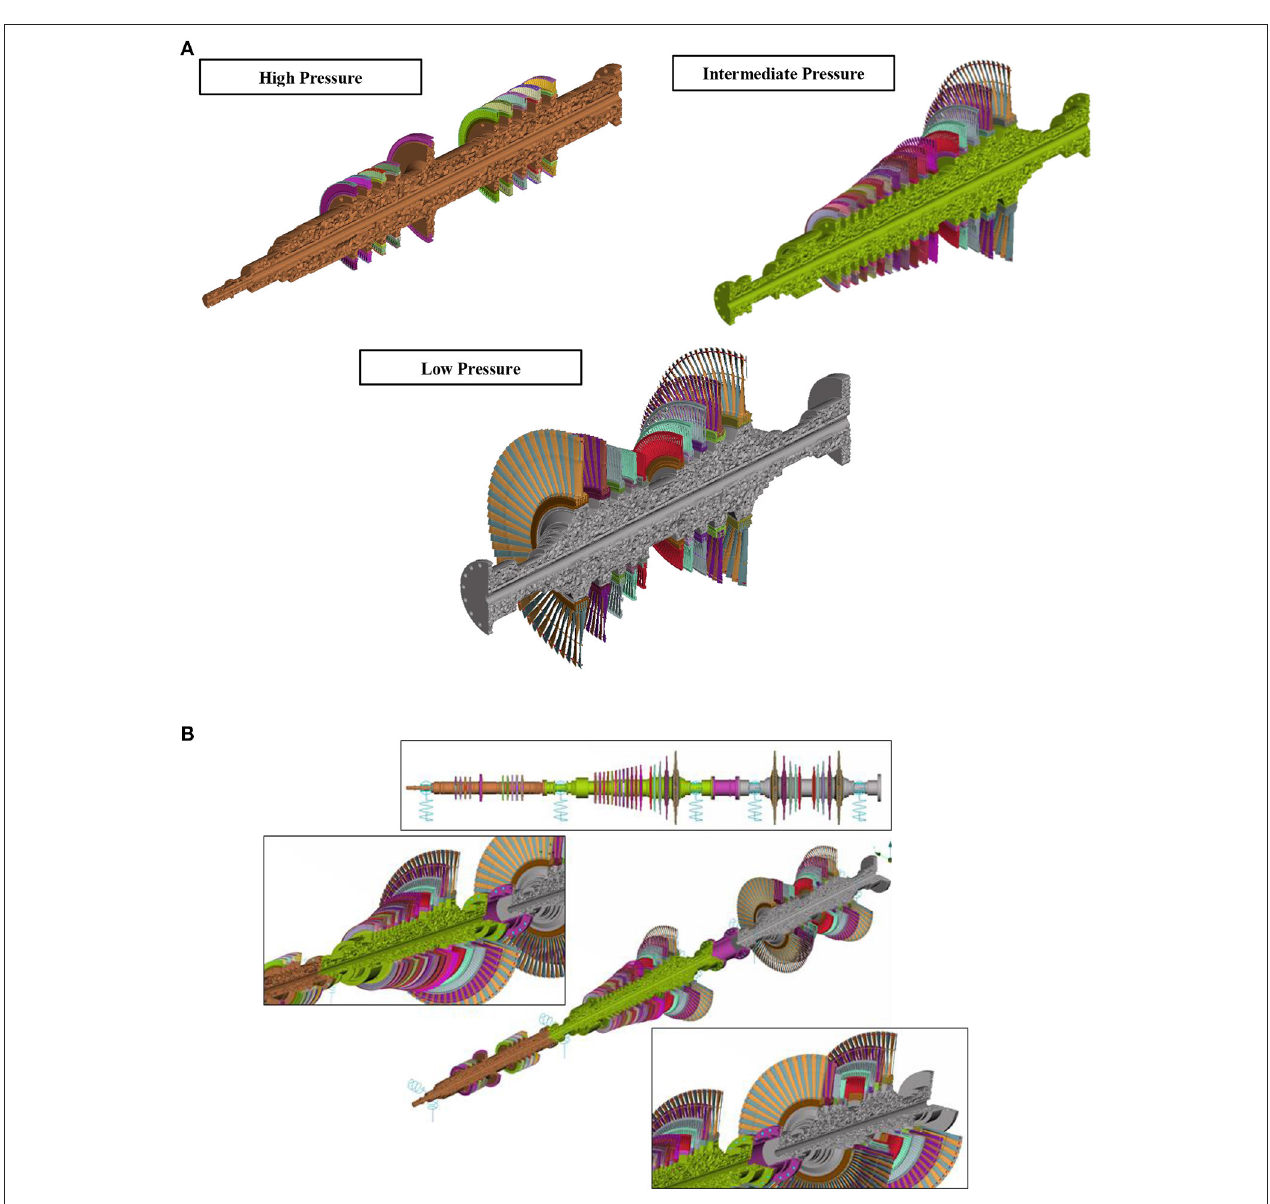
FIGURE 5 | (A) Detailed FE models of the high, intermediate, and low pressure turbines. (B) Detailed FE models of the complete steam turbine.